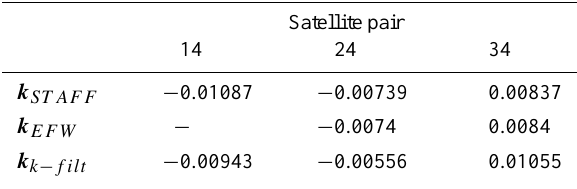
Table 2. Wave vectors ( k ) projected along the satellite separation vectors. The frequency used was 0.37Hz. The values were deter- mined using a phase-based method with both STAFF-SC ( k STAFF ) and EFW electric field ( k EFW ) and by applying the k-filtering method to the STAFF-SC data set.